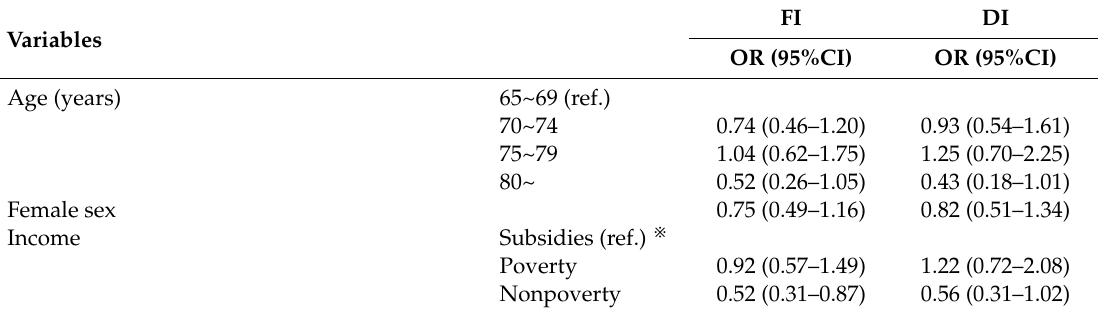
Table 5. Multivariate analysis of factors associated with FI and